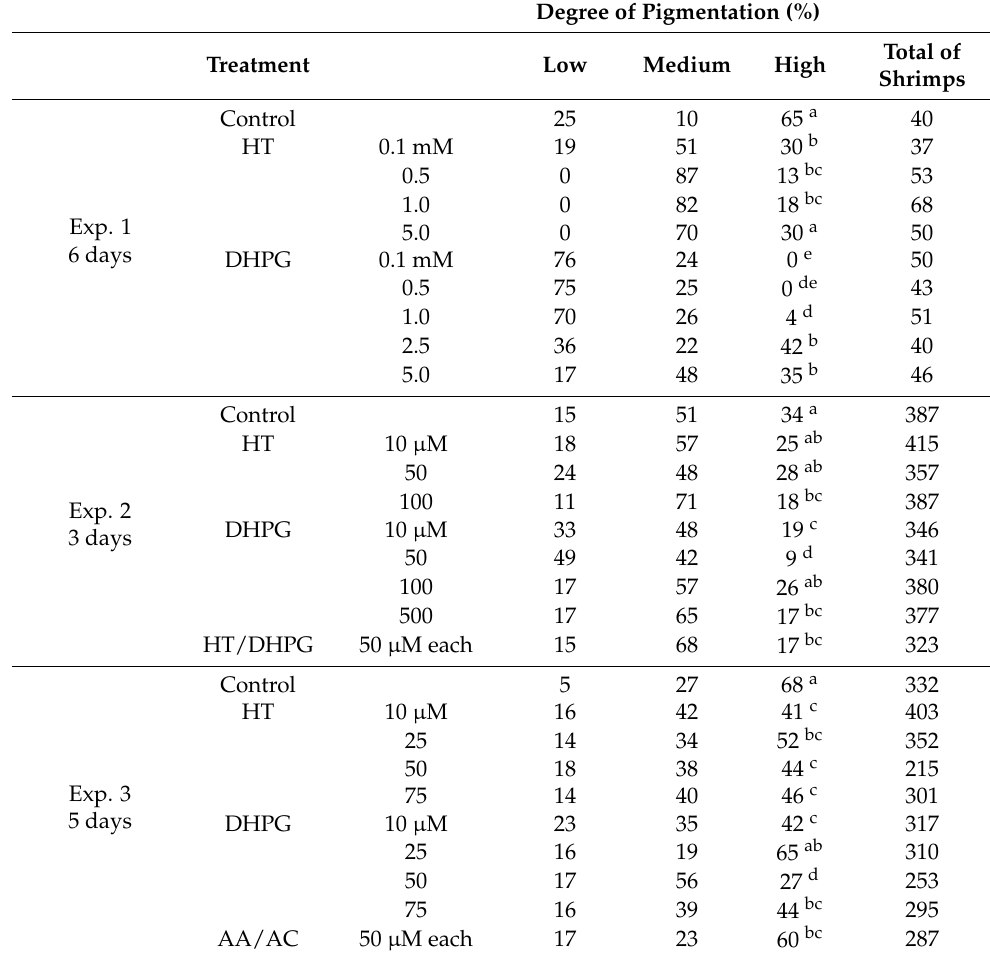
Table 1. Melanosis score evaluated as degree of pigmentation (low, medium, and high) during refrig- erated storage at 4–6 ◦ C of shrimps treated for 30 min with different concentrations of hydroxytyrosol (HT), 3,4-Dihydroxyphenylglycol (DHPG), and a mixture (1:1) of ascorbic and citric acids (AA/CA) a . Degree of Pigmentation (%) Total of Treatment Low Medium High Shrimps